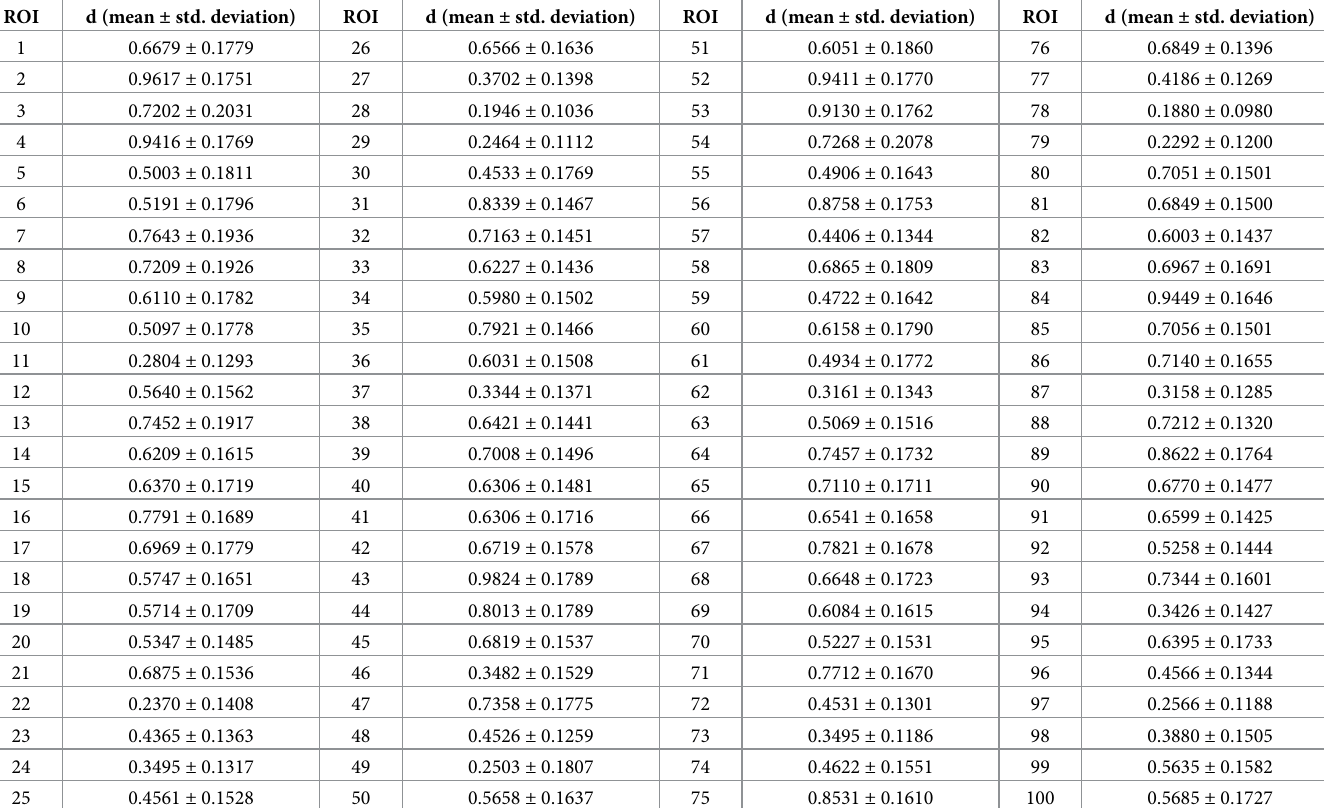
Table 1. Mean value of the fractional difference parameter d averaged across the ROIs of all 98 subjects in all 4 sessions (i.e., 98 ×